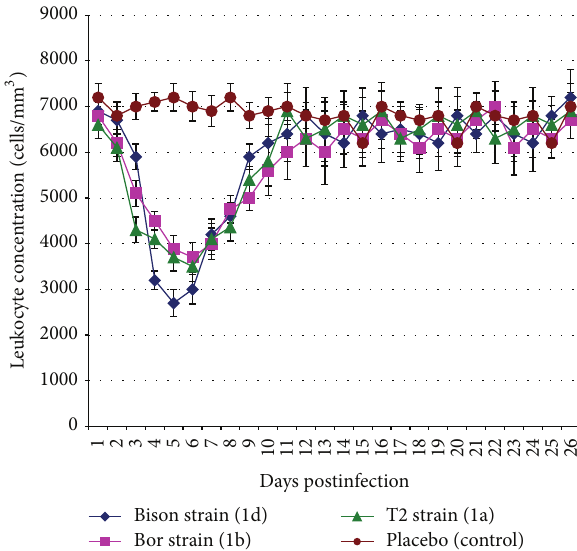
Figure2:Thedataonthedynamicsofleukocyteconcentrationin4– 6-month-old calves after aerosol challenge by bovine viral diarrhea virusdifferentnoncytopathicstrainsoftype1withthedoseof6 log 10 TCD 50 . The values are presented as 𝑀±𝐼 95 ( 𝑀 , mean value; 𝐼 95 , 95% confidence interval) for 𝑛 = 3 , the number of animals per time point (1–10 days postinfection, p.i.); 𝑛 = 2 , the number of animals per time point (11–25 days p.i.); values obtained for the three strains 3–9 days p.i. are lower than in the control according to Mann-Whitney 𝑈 test and Student’s 𝑡 -test at 𝑝 ≤ 0.05 ; values obtained for Bison strain 4–6 days p.i. are less than for Bor and T2 strains according to Mann- Whitney 𝑈 test and Student’s 𝑡 -test at 𝑝 ≤ 0.05 ; values obtained for Bor strain 3 days p.i. are less than for T2 and Bison strains according to Mann-Whitney 𝑈 test and Student’s 𝑡 -test at 𝑝 ≤ 0.05 .